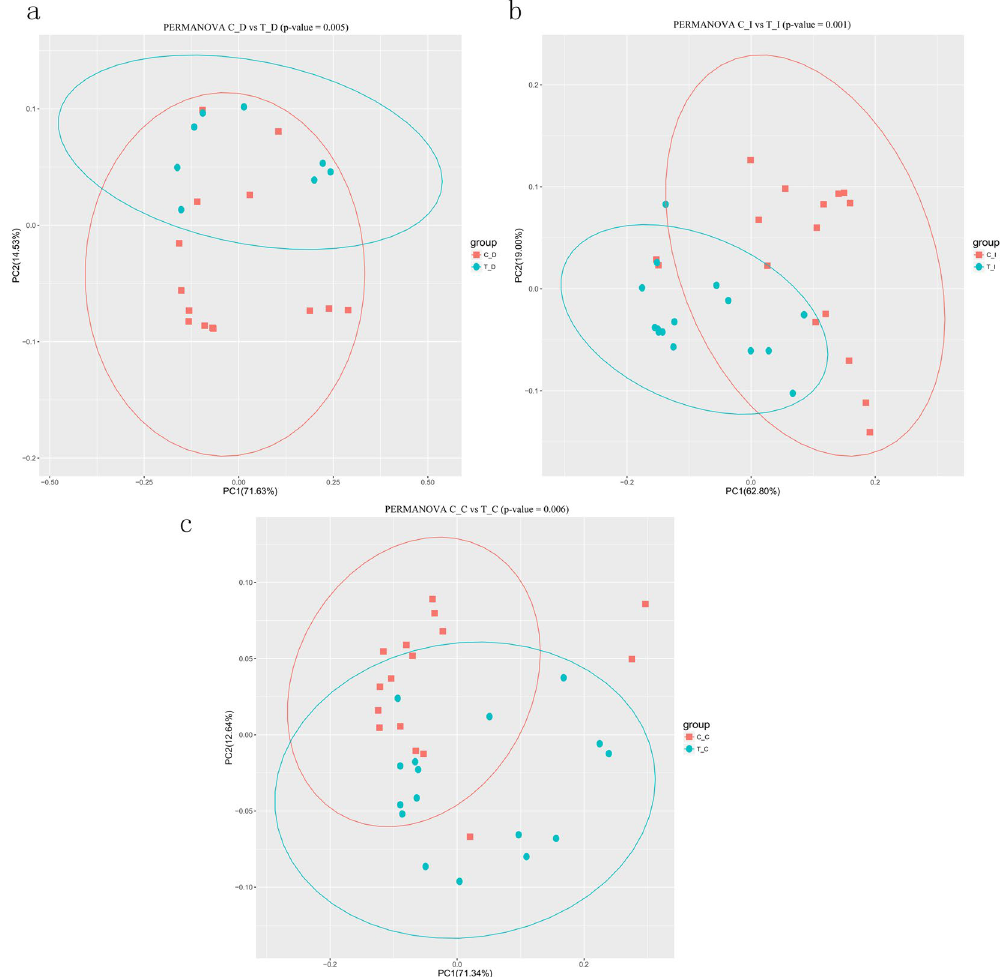
Figure 2. The overall luminal microbiota structures of Shaoxing ducks under different rearing conditions showed by Principal Coordinate Analysis of Weighted UniFrac Distances of RLF and RPMF ducks. Red and blue colors represent the RLF and RPMF duck samples, respectively. The significant separation between the 2 rearing conditions were observed in the duodenum ( a ), the ileum, ( b ), and the cecum ( c ).